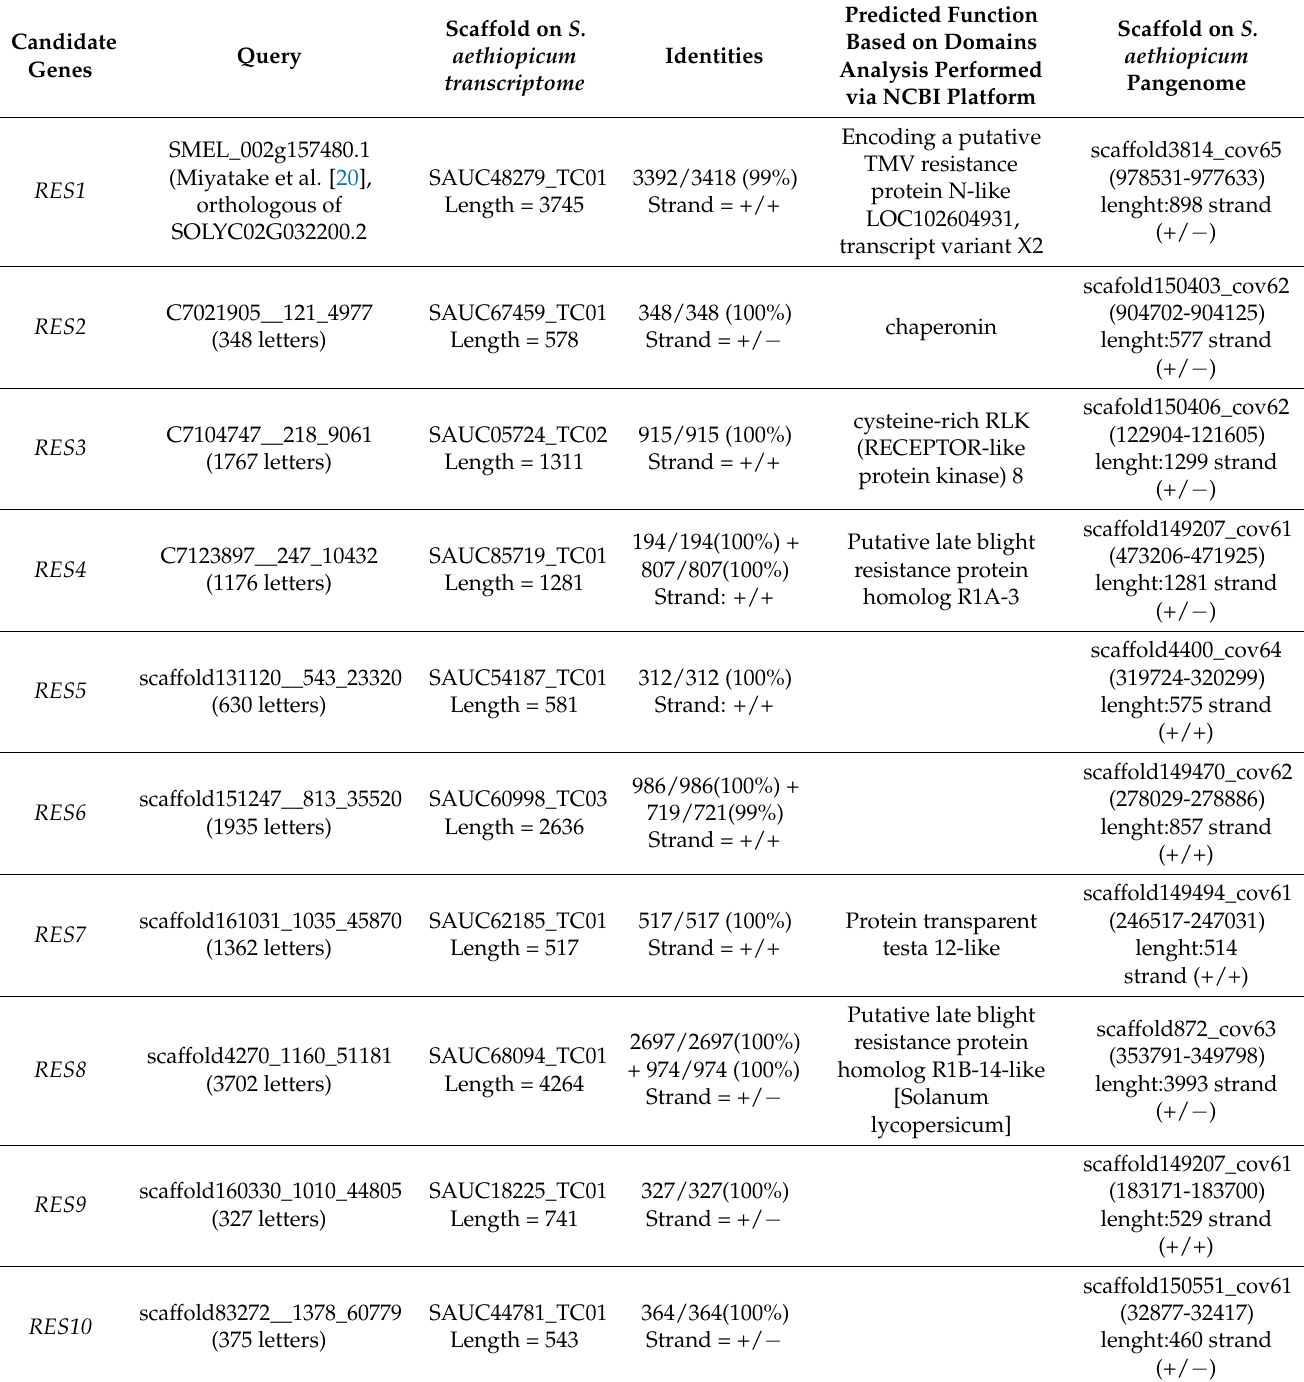
Table 6. List of best candidate genes identified among the overrepresented bulks of reads from resistant RILs and with the best match with transcriptome data of S. aethiopicum . For each gene, the 305_asm scaffold or contig, the matching S. aethiopicum scaffold (from Gramazio et al. [59]), the percentage of homology and a putative gene prediction are